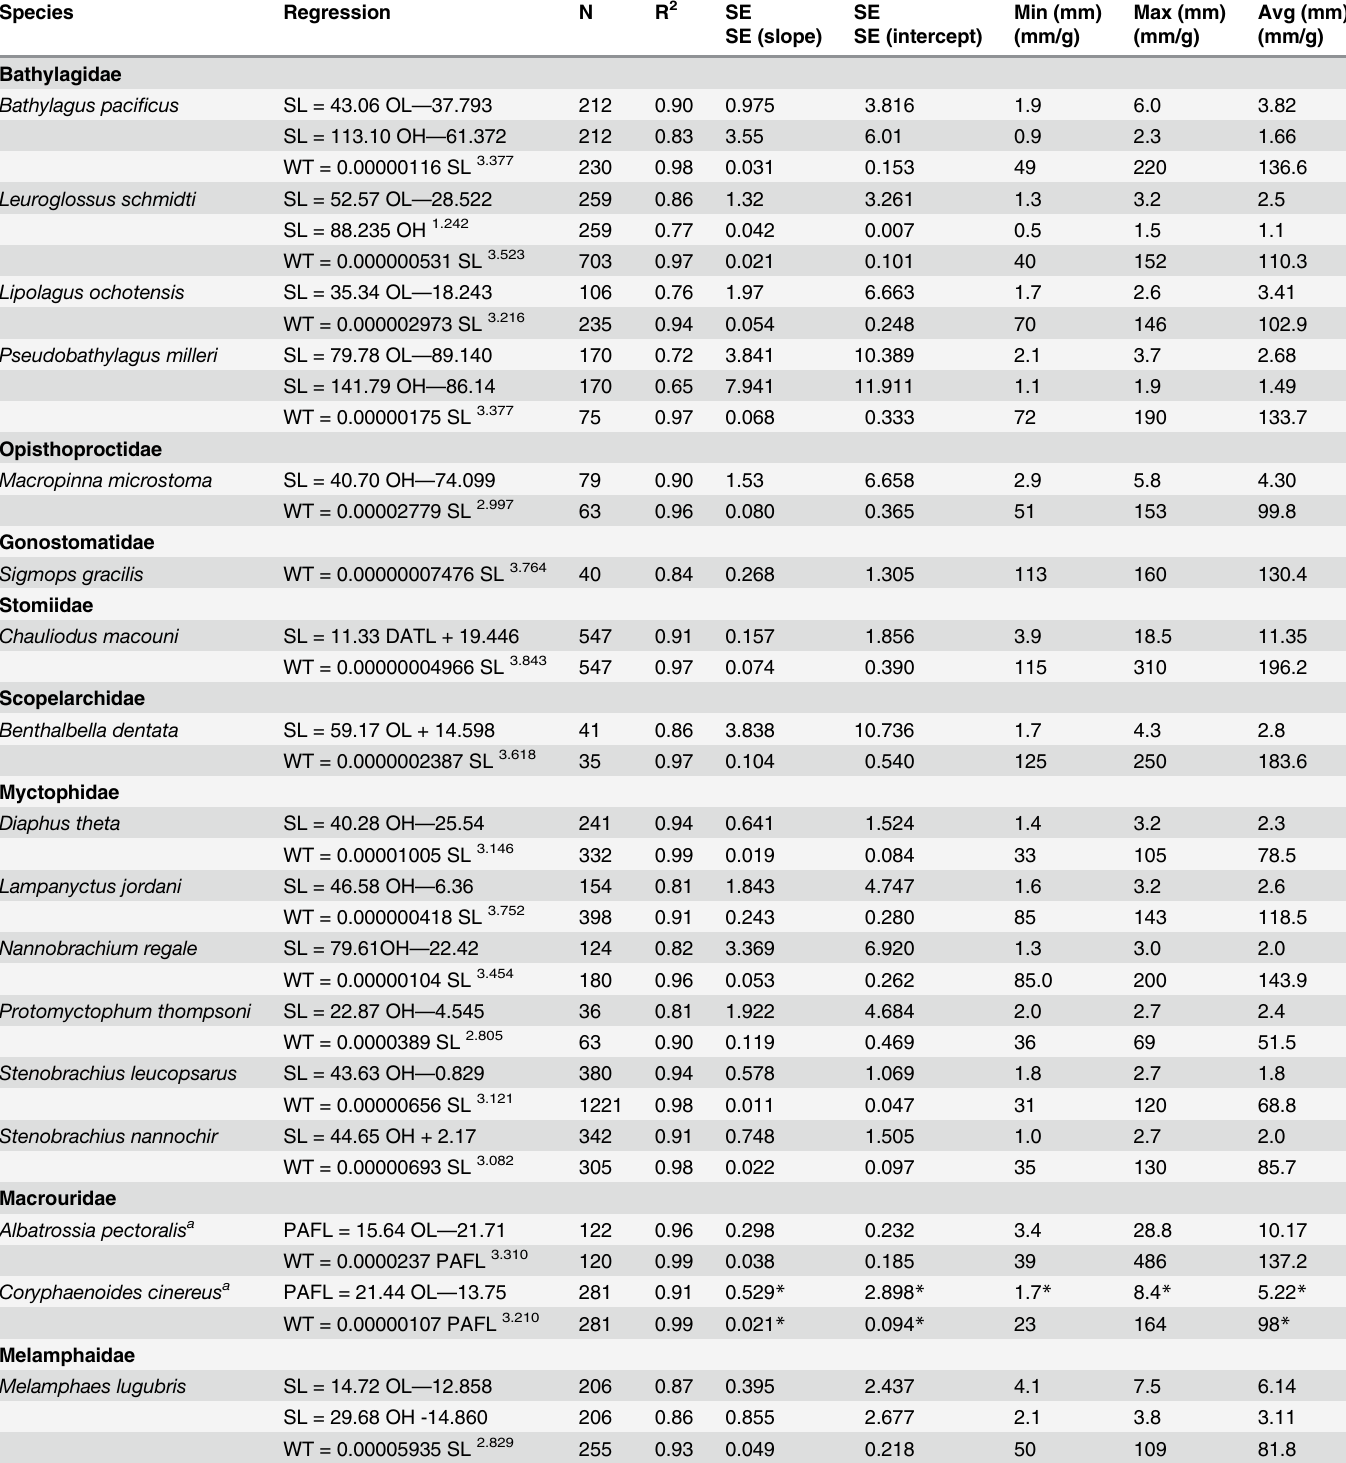
Table 1. Fish length and weight regression equations. Otolith height (OH), otolith length (OL) or dentary anterior tooth length (DATL) were measured (mm) and regressed on standard length (SL) or pre-anal fin length. Standard length or PAFL were regressed on weight (WT) (g).